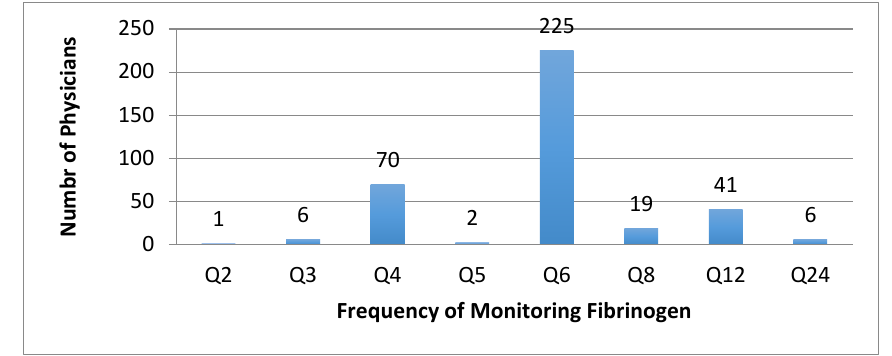
Figure 4. Reported protocol for frequency of monitoring fibrinogen levels during thrombolysis. Q2 = every 2 h, Q3 = every 3 h, Q4 = every 4 h, Q5 = every 5 h, Q6 = every 6 h, Q8 = every 8 h, Q12 = every 12 h, Q24 = every 24 h.